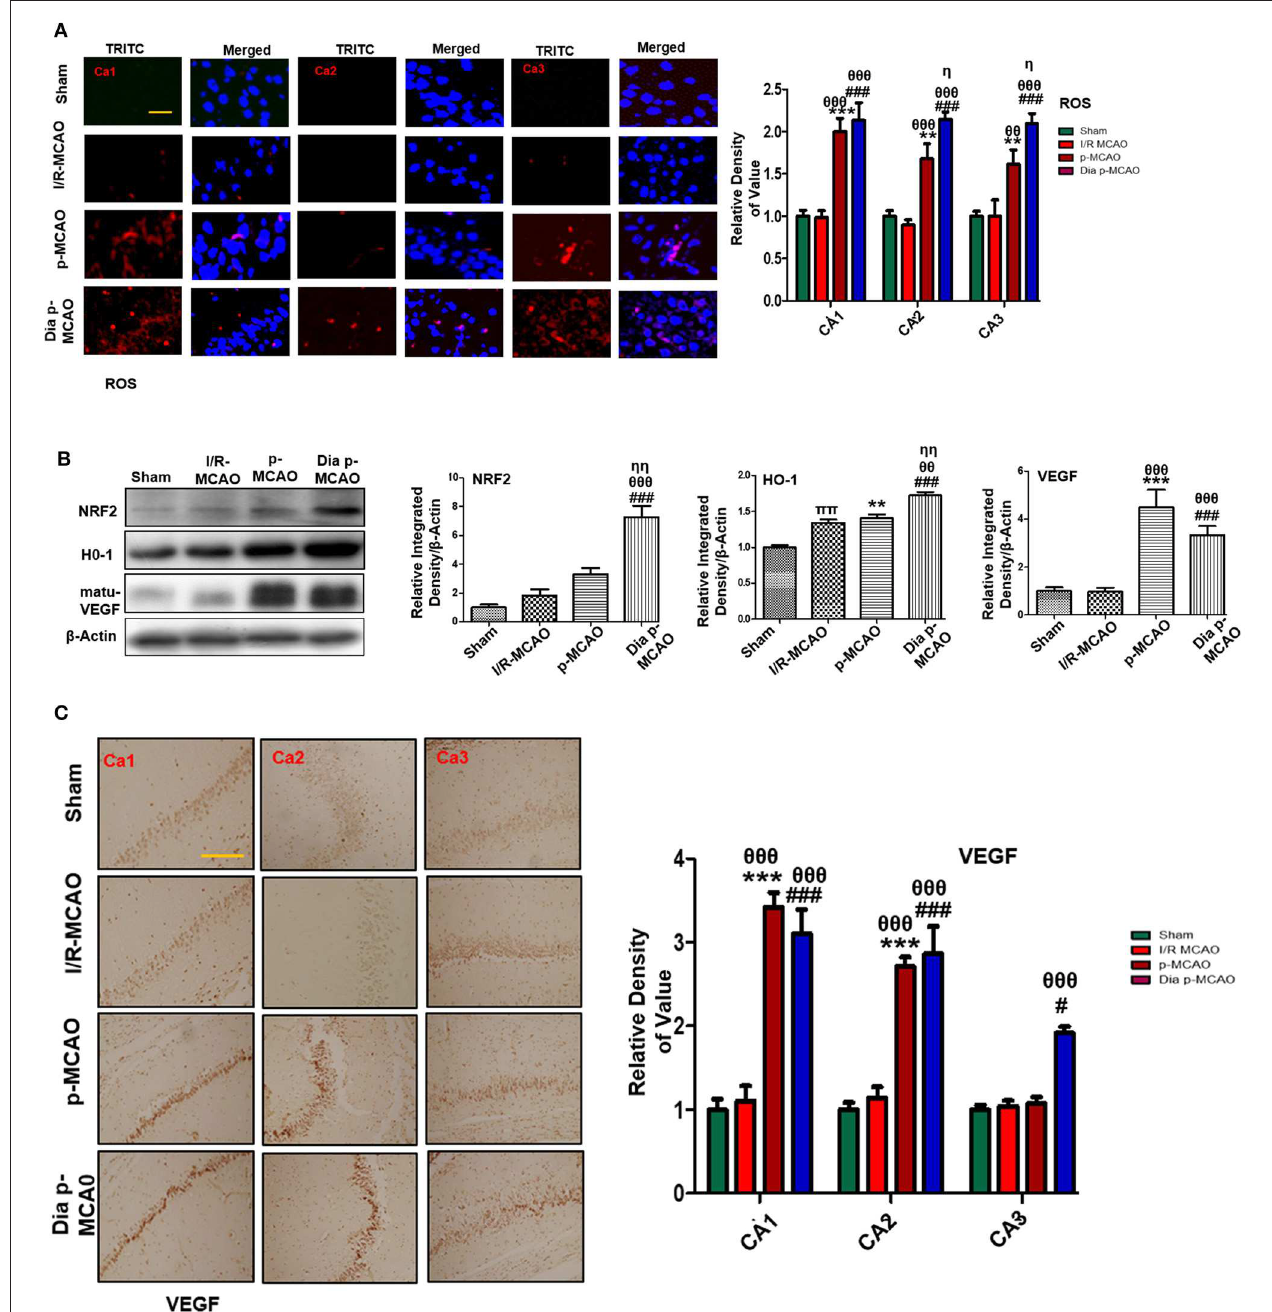
FIGURE 6 | Effect of ischemia on oxidative distress (A) Representative immunofluorescence images of 8-oxoguanine staining indicate comparative expression of ROS in various CA1, CA2, and CA3 region of hippocampus ( n = 5/group, Scale bar = 100 µ m). (B) Western blot analysis of NRF2, HO-1, matu-VEGF. Densitometric analysis was expressed in relative to β -Actin ( n = 5/group) (C) Representative images of VEGF immunohistochemistry; scale bar = 50 µ m. The CA1, CA2, and CA3 segments in p-MCAO and Dia p-MCAO showing elevated expression of VEGF ( n = 5/group). θ p < 0.05 relative to I/R MCAO, η p < 0.05 between p-MCAO and Dia p-MCAO. * p < 0.05, # p < 0.05, and π p < 0.05 relative to sham group. *** p < 0.001, ** p < 0.01, and ### p < 0.001. θθ shows significant difference of p-MCAO and Dia p-MCAO to I/R, and its value is p < 0.01, θθθ shows significant difference of p-MCAO and Dia p-MCAO to I/R, and its value is p < 0.001, ηη shows significant difference between p-MCAO and Dia p-MCAO, and its value is p < 0.01, ππ shows significant difference of I/R MCAO to sham, and its value is p < 0.01.